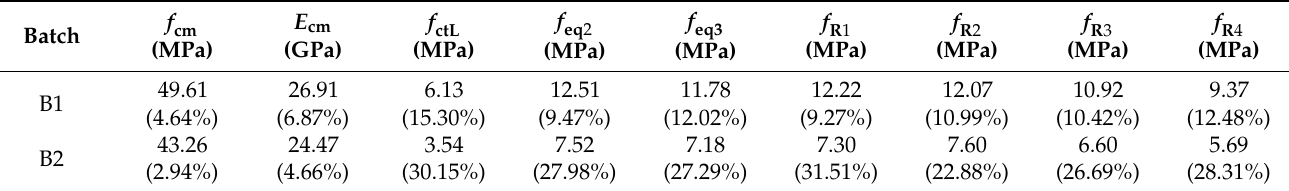
Table 2. Properties of the FRC (mean values).